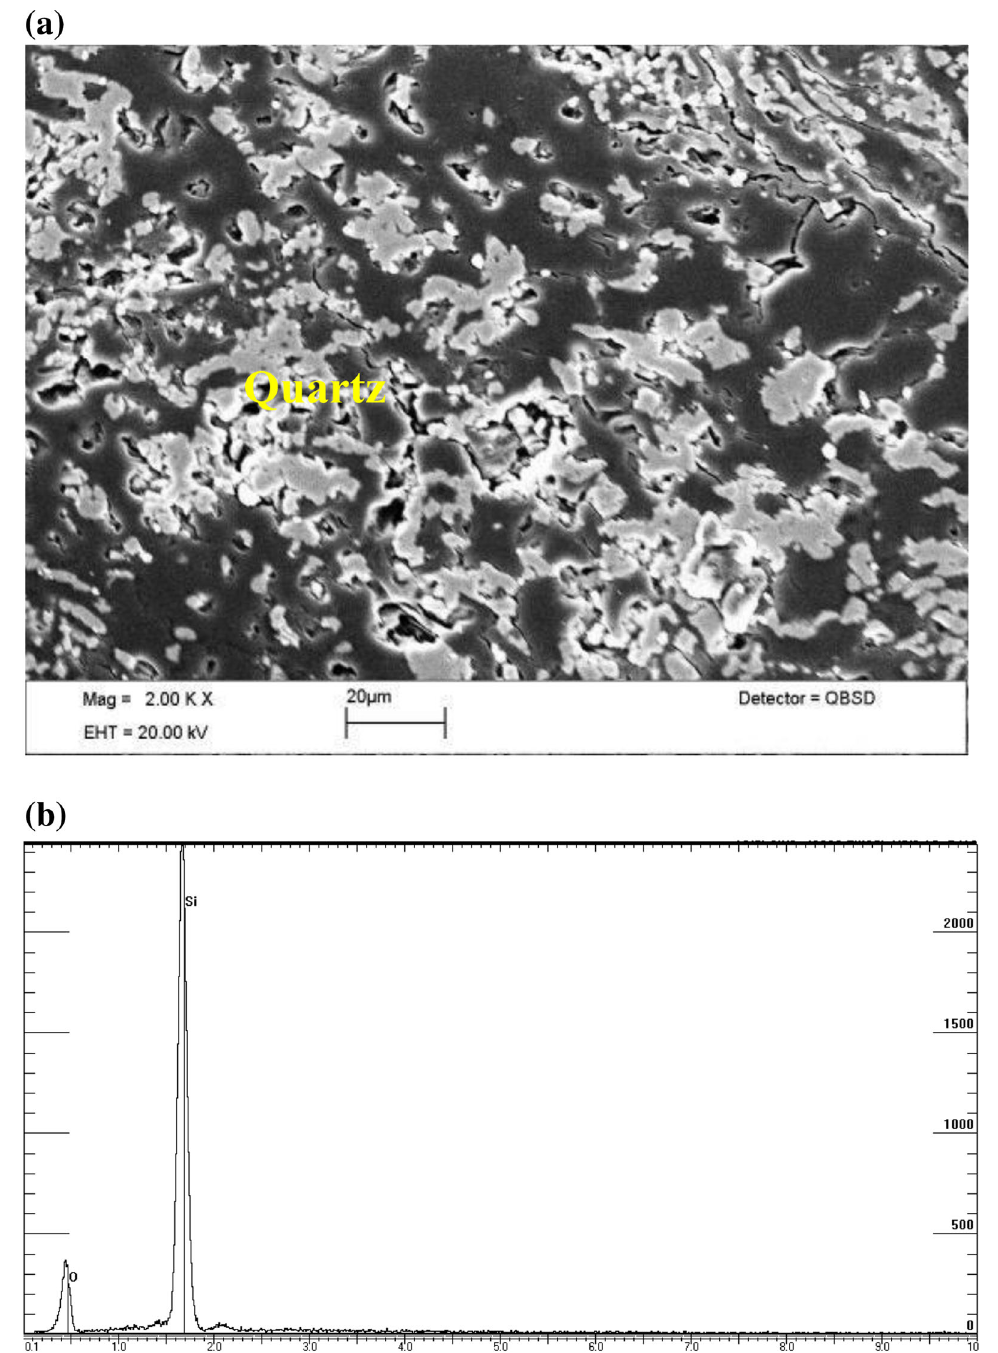
Fig. 2 Quartz in fusinite lumens. a SEM backscattered electron image. b X-ray energy spectrum diagram, spot